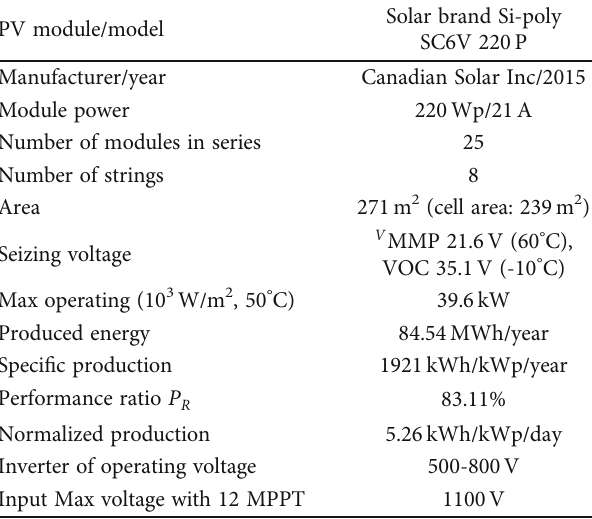
Table 1: PV module parameters, speci fi cations, and